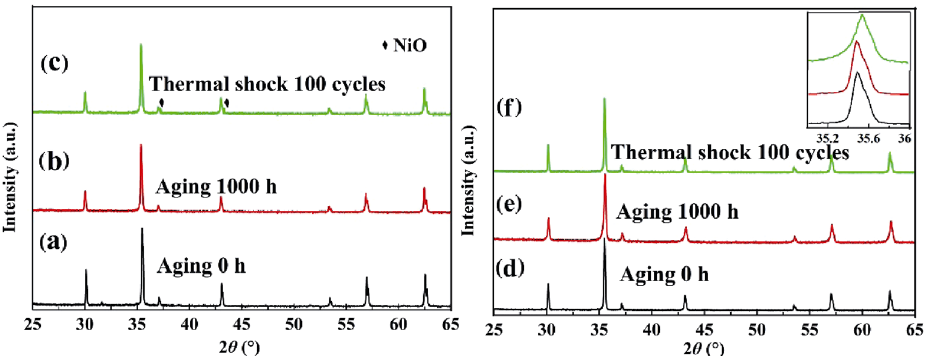
Fig. 15 XRD patterns of A0 ceramic after the aging process after (a) 0 h, (b) 1000 h, and (c) 100 thermal shock cycles, and A2 ceramic during aging after (d) 0 h, (e) 1000 h, and (f) 100 thermal shock cycles.